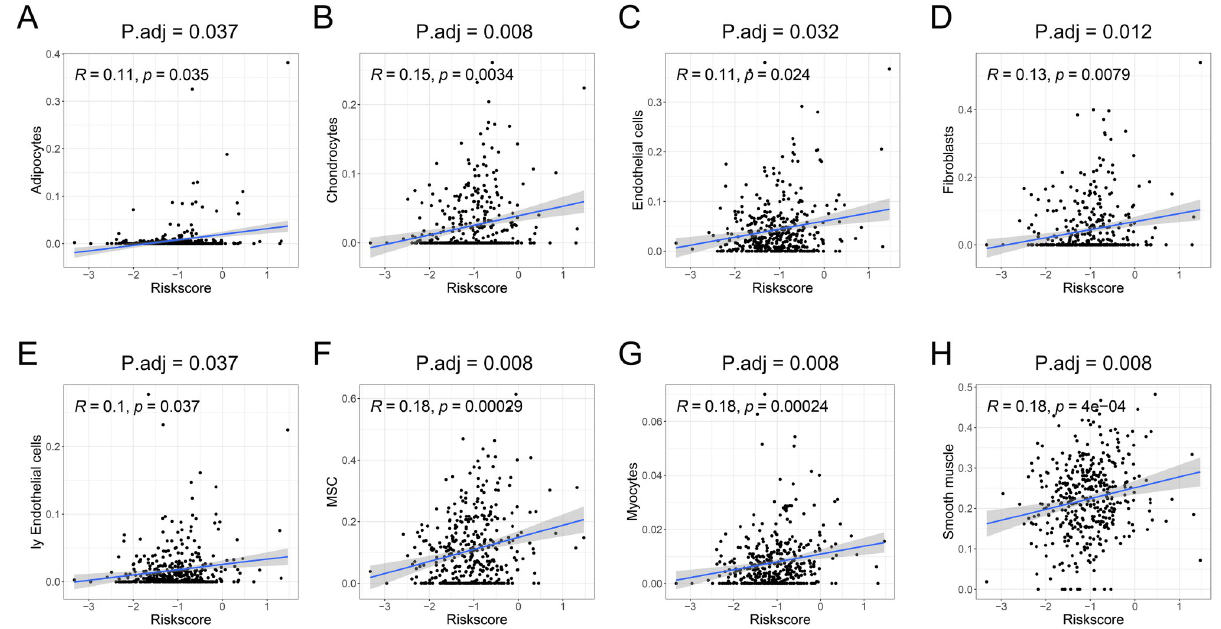
Fig 9. Stromal cells in BC patients based on the xCell algorithm. Results indicated that enrichment of signatures of eight stromal cells [adipocytes (A), chondrocytes (B), endothelial cells (C), fibroblasts (D), ly endothelial cells (E), MSCs (F), myocytes (G) and smooth muscle (H)] from the TME in the high-risk group. BC, bladder cancer; MSCs, mesenchymal stem cells; ly endothelial cells, lymphatic endothelial cells; TME, tumor microenvironment; P. adj, P.